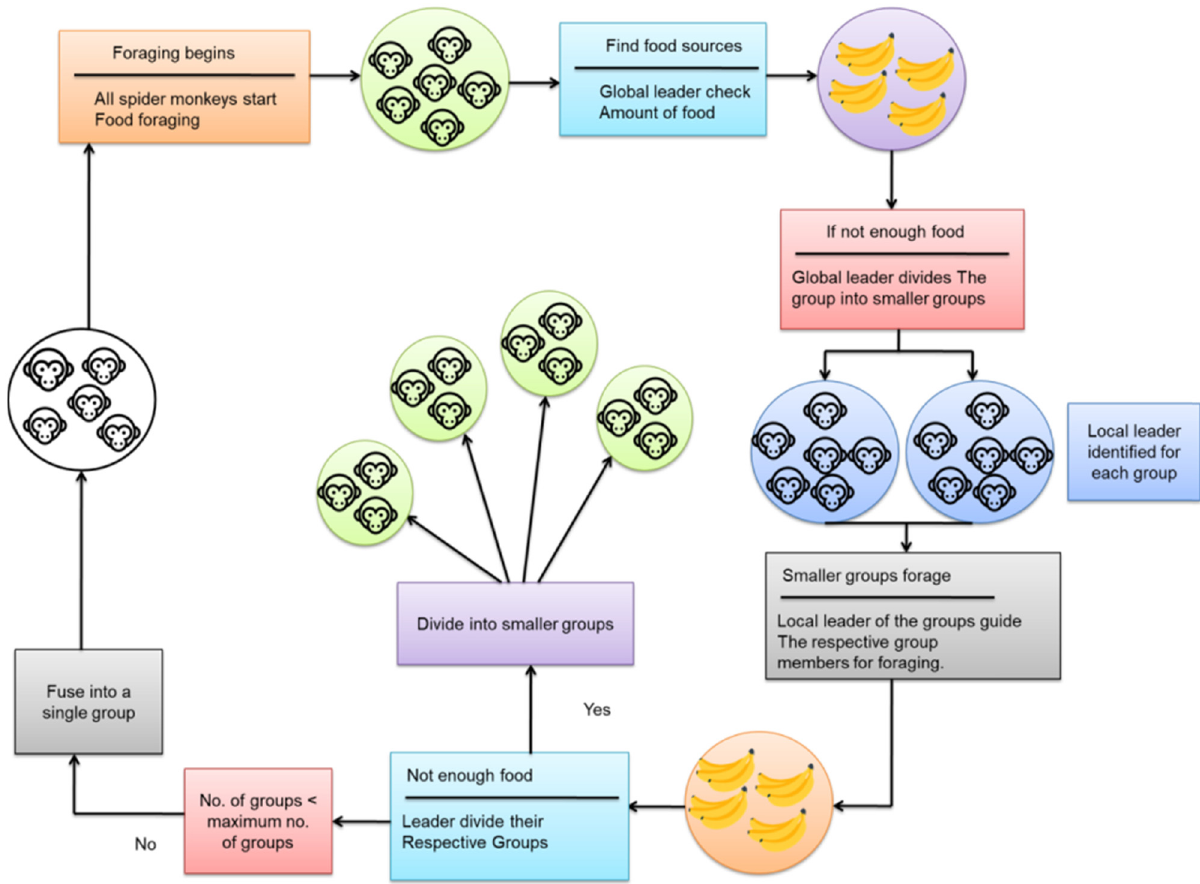
Figure 4: Foraging behavior of spider